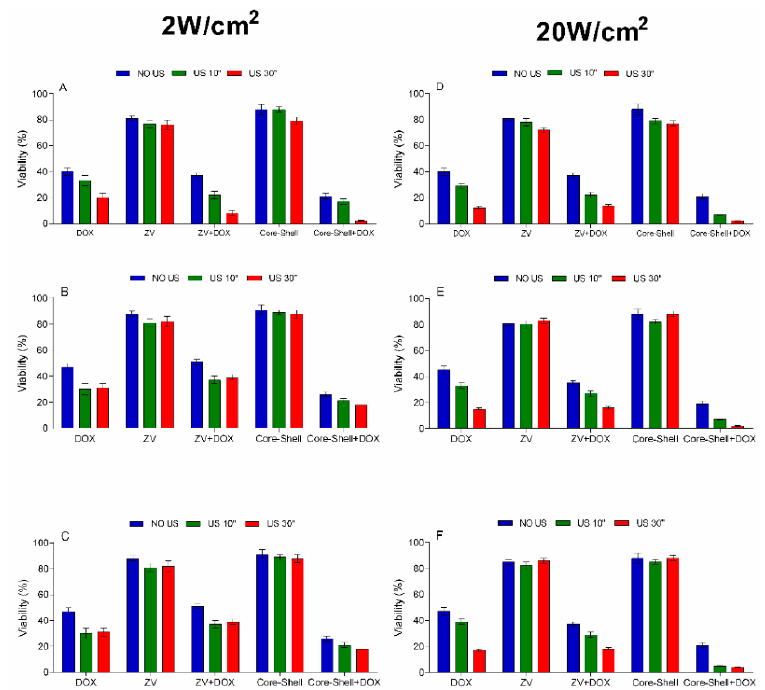
Figure 6. Cell viability evaluation for all formulations with and without application of US (concentration of particles: 50 μ g/mL): ( A , B, C) 2 W/cm 2 and ( D , E, F) 20 W/cm 2 . The cells were incubated with the core–shell samples at the concentration of 50 μ g/mL and treated with five US cycles within 110 minutes (the timing used for the release was followed). Values are reported as averages, and error bars represent the SD (n = 3).